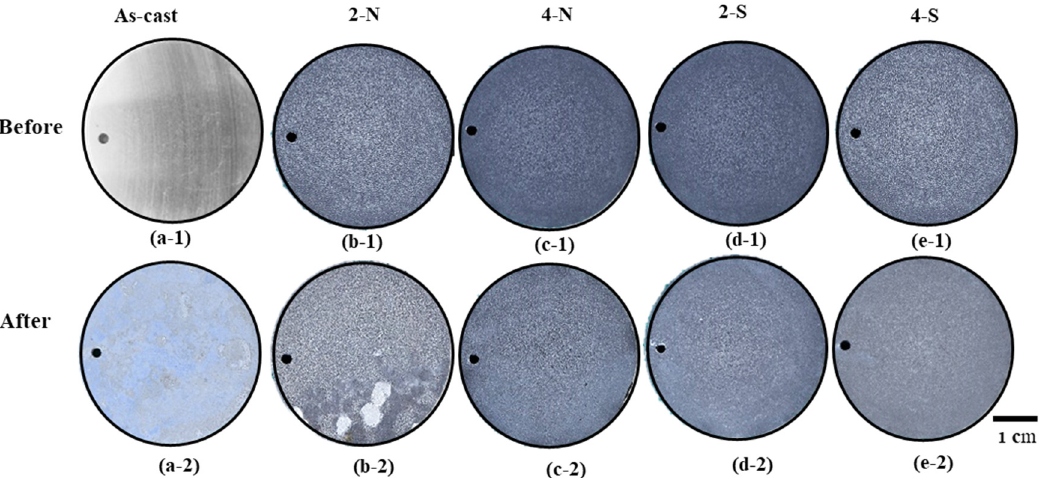
Figure 11. Appearances of the alloys, anodized and sealed before salt spray testing after 14 days: ( a-1 ) and ( a-2 ) as-cast A535 alloy; ( b-1 ) and ( b-2 ) 2-N; ( c-1 ) and ( c-2 ) 4-N; ( d-1 ) and ( d-2 ) 2-S; and ( e-1 ) and ( e-2 ) 4-S (optical microscopy).